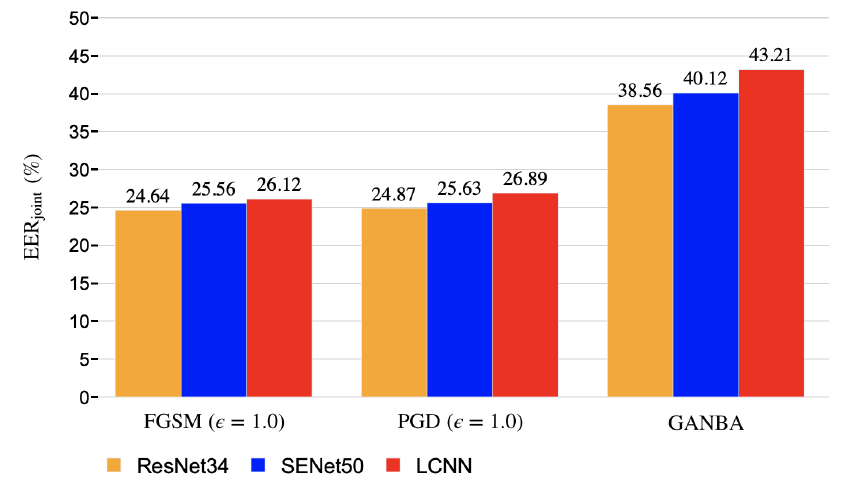
Figure 6. EER joint (%) of the black-box adversarial spoofing attacks evaluated on the ASVspoof 2019 physical access (PA) test dataset with the state-of-the-art TDNN + PLDA/LCNN biometric system. There are three attackers (student systems) which use the ResNet34, SENet50 and LCNN as PAD sys- tem, respectively. The ASV system of the attacker is a TDNN + b-vector system. Every student system generates three types of attacks: FGSM ( (cid:101) = 1.0 ) , PGD ( (cid:101) = 1.0 ) and the proposed GANBA attack.